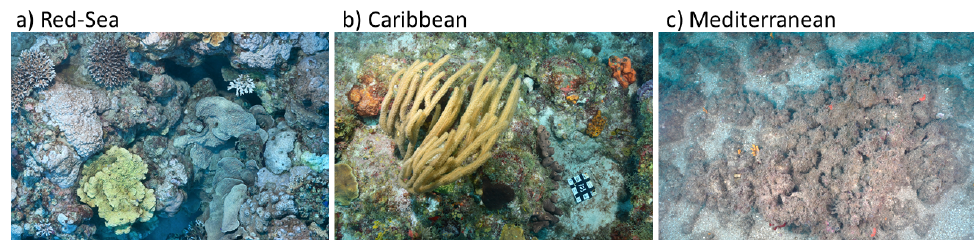
Figure 2. The main challenges in benthic image segmentation are due to plasticity, irregular shapes, and elaborate 3D structures. ( a ) The benthic community structure in Eilat, the Red Sea, is composed mainly of Scleractinian corals. ( b ) The reefs in the eastern Caribbean are shifting towards a sponge and soft-coral dominated community. ( c ) In the eastern Mediterranean, the rocky reef is temporarily dominated by turf